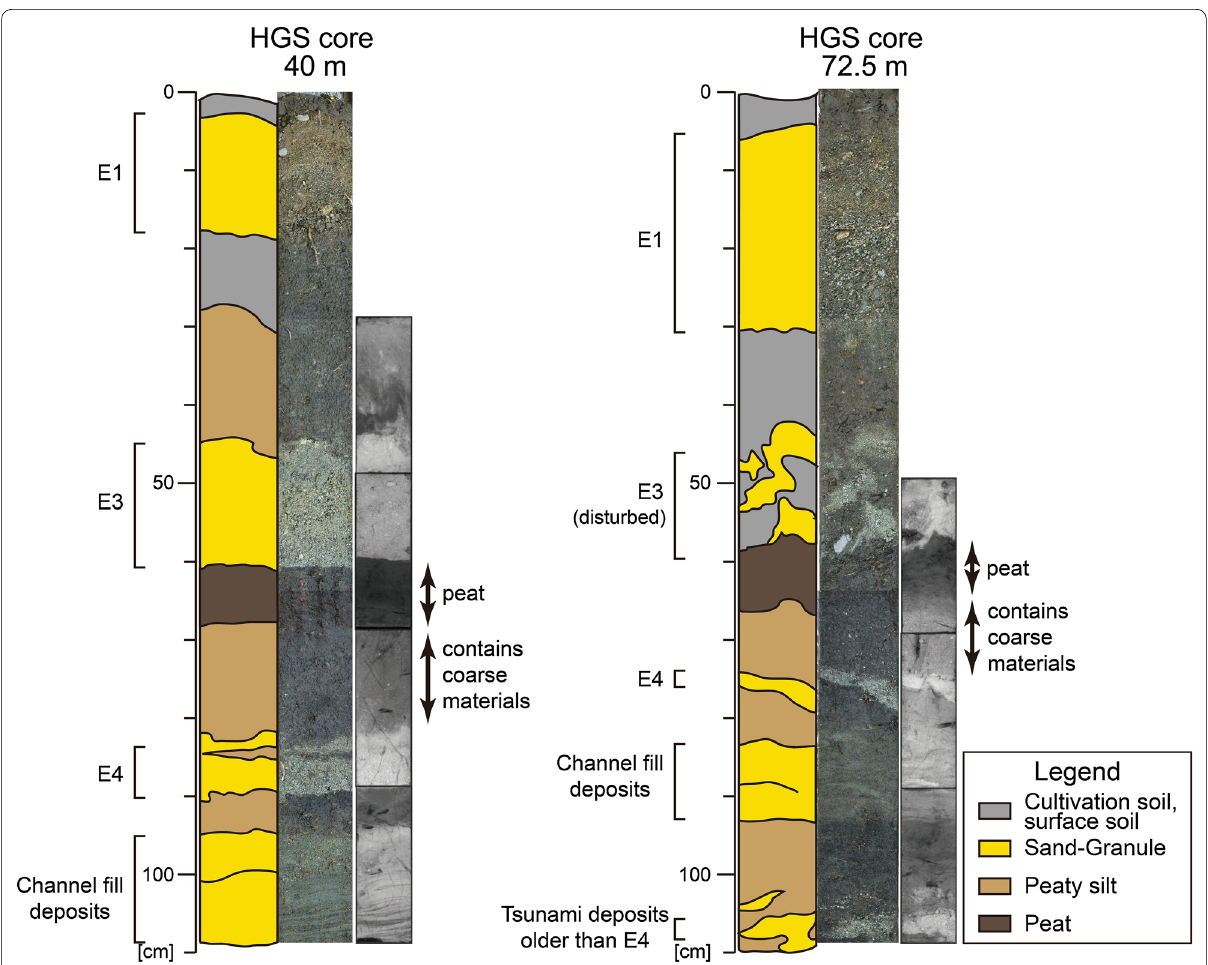
Fig. 6 Soft X-ray images and sketches of the HGS cores at 40 and 72.5 m. All sketches of the HGS cores and subsurface profile are shown in Addi- tional file 2: Figure